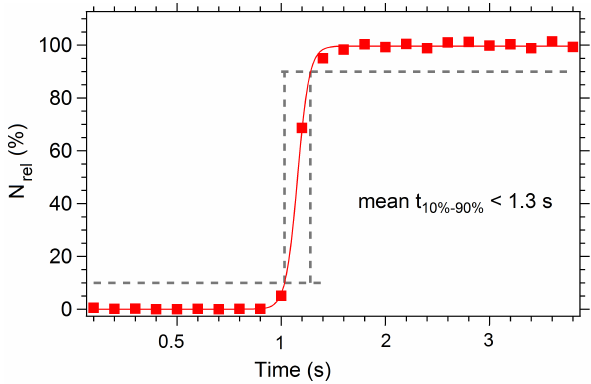
Figure 5. The mean response time of 1.3s was initiated by a high increase in number concentration that is represented by the relative number concentration ( N rel ) during a calibration in the